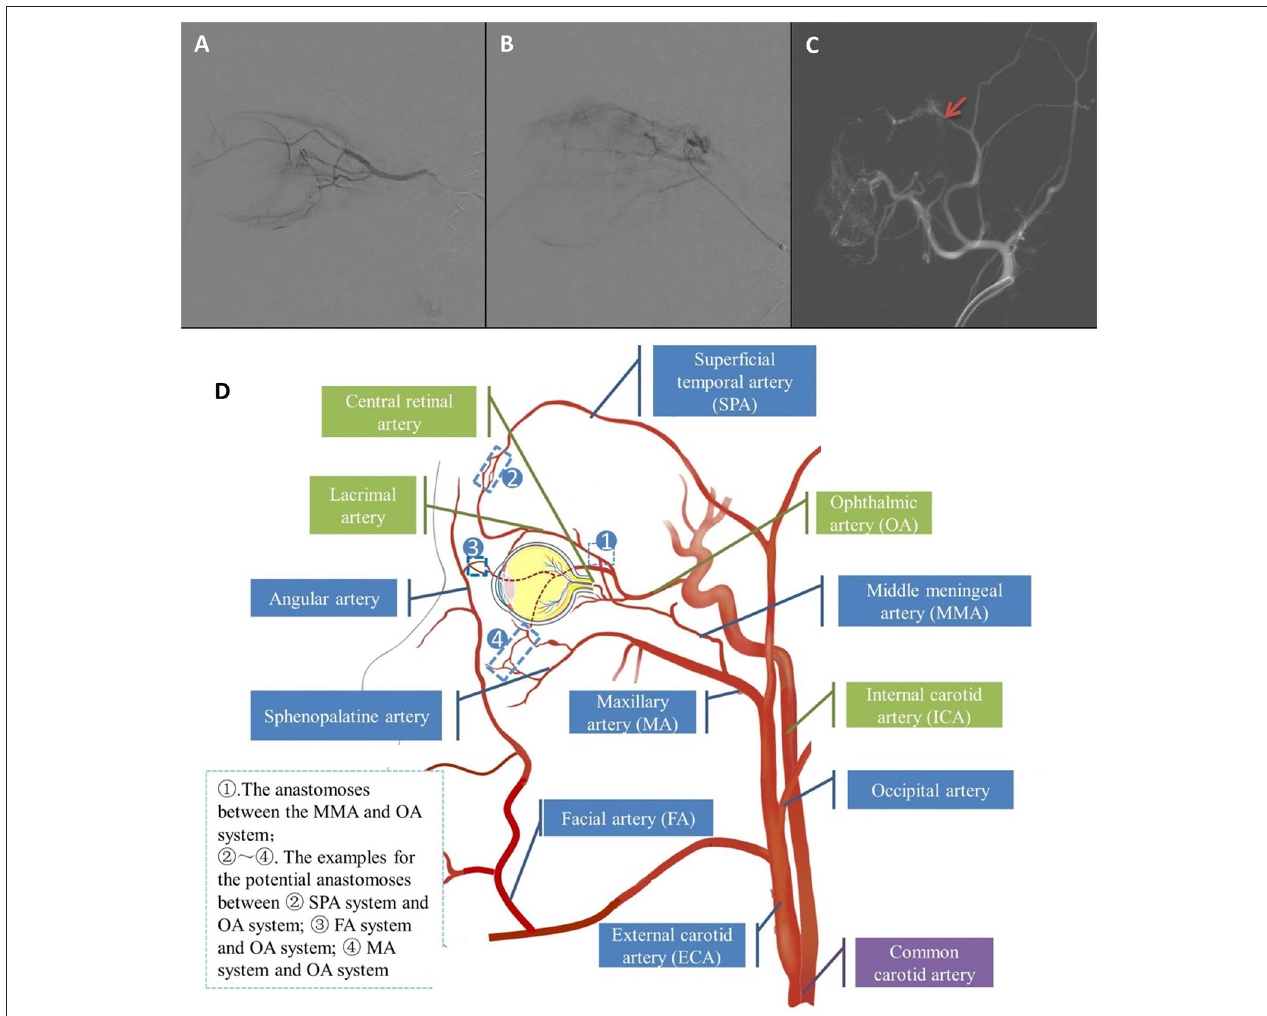
FIGURE 1 | (A) Representative angiography of direct OA catheterization. (B,C) Representative angiography of alternative MMA approach catheterization (Red arrow showed where the catheter was advanced). (D) Schematic illustration of the branches of OA and ECA and their several potential anastomoses.